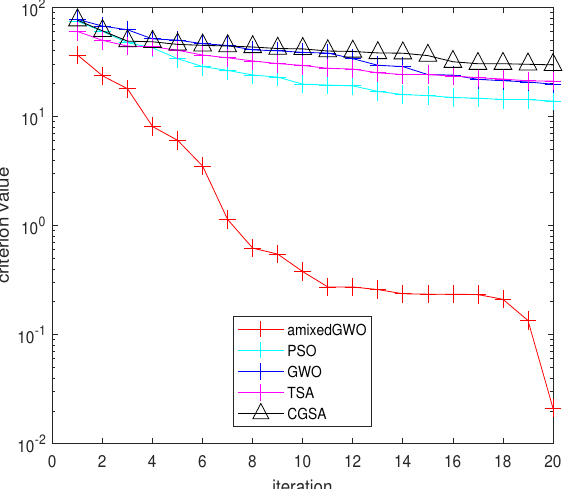
Figure 17. Geometric mean (semi-log scale) of the convergence curves for amixedGWO, PSO, GWO, TSA, CGSA.